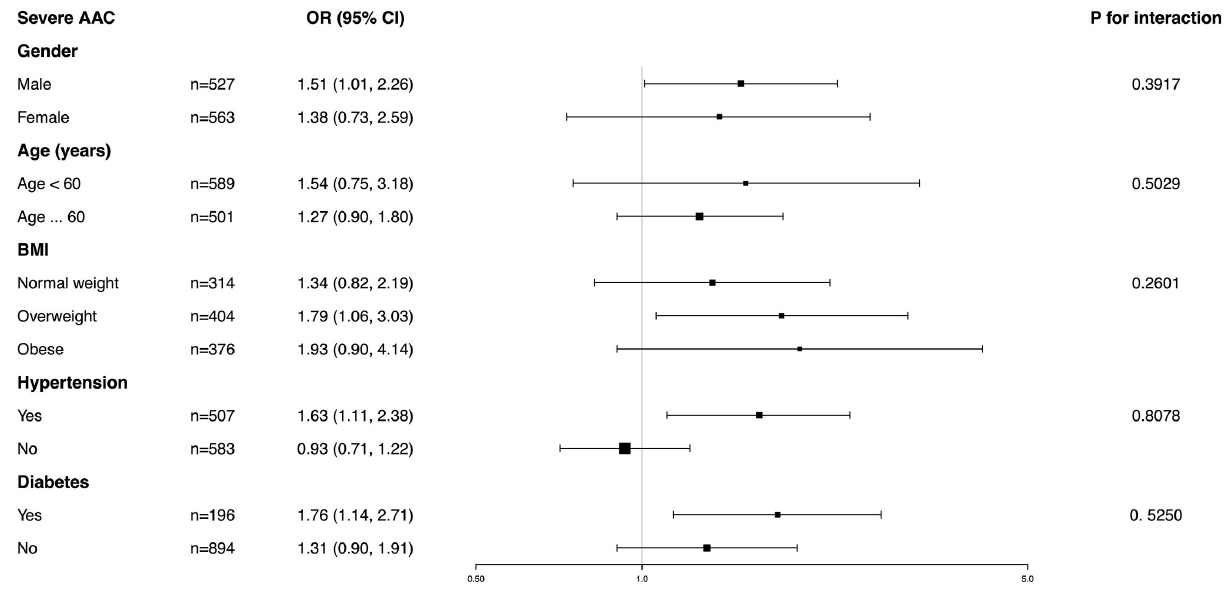
FIGURE 5 | Subgroup analysis for the association between BCC and severe